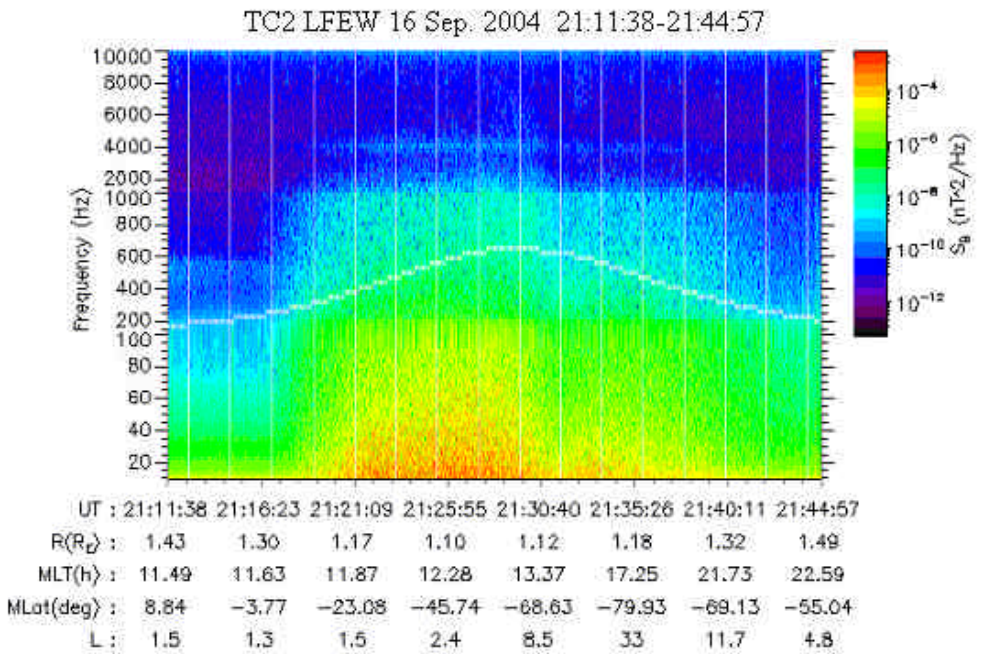
Fig. 4. Ion cyclotron waves observed by LFEW on 16 September 2004.